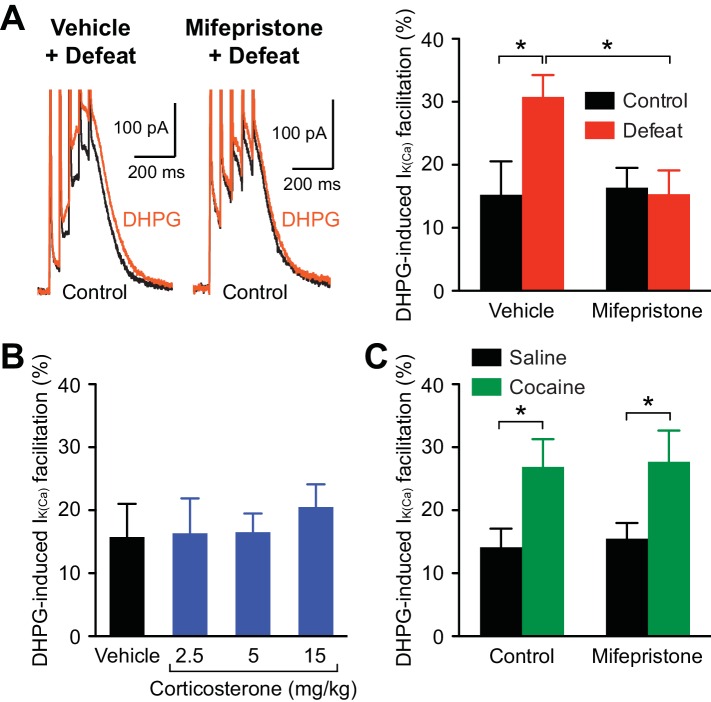
Stress-induced, but not cocaine-induced, IP3R sensitization is prevented by GR blockade.(A) Example traces (left) and summary (right) of DHPG-induced burst IK(Ca) facilitation in neurons from animals that were injected with vehicle or mifepristone before undergoing control handling or social defeat sessions (vehicle + control: 8 cells from 5 rats, vehicle + defeat: 10 cells from 4 rats, mifepristone + control: 10 cells from 5 rats, mifepristone + defeat: 11 cells from 4 rats; defeat × mifepristone: F1,35 = 4.56, p<0.05, two-way ANOVA). *p<0.05 (Bonferroni post hoc test). (B) Summary bar graph showing that repeated corticosterone treatment (once daily for 5 days) failed to affect DHPG-induced burst IK(Ca) facilitation (vehicle: 8 cells from 5 rats, 2.5 mg/kg: 11 cells from 5 rats, 5 mg/kg: 10 cells from 4 rats, 15 mg/kg: 12 cells from 7 rats). (C) Summary bar graph demonstrating that mifepristone pretreatment failed to block the increase in DHPG effect resulting from repeated cocaine treatment (10 mg/kg, i.p., once daily for 5 days) (saline: 17 cells from 7 rats, cocaine: 16 cells from 7 rats, mifepristone + saline: 21 cells from 8 rats, mifepristone + cocaine: 16 cells from 6 rats; cocaine: F1,66 = 11.4, p<0.01, two-way ANOVA). *p<0.05 (Bonferroni post hoc test).